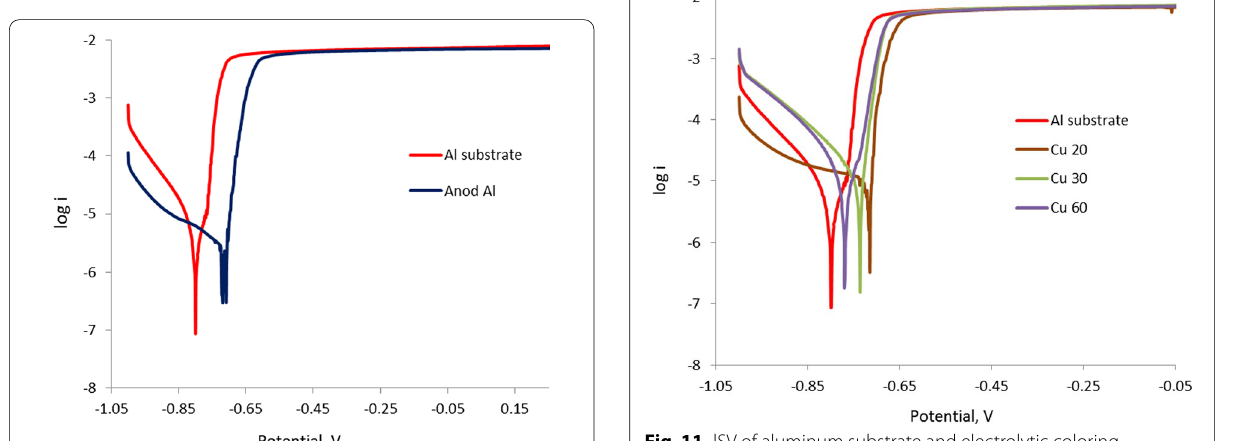
Fig. 11 lSV of aluminum substrate and electrolytic coloring aluminum samples by Cu in 3.5% NaCl solution at